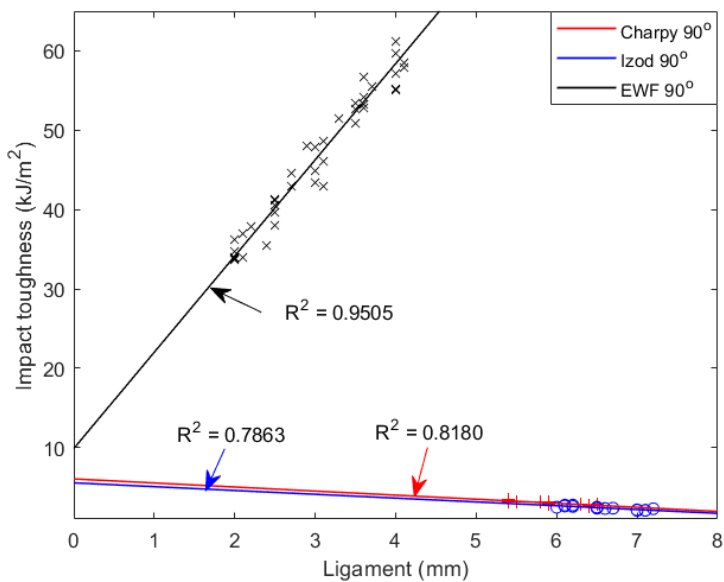
Figure 7. Comparison of the fracture energy calculated by different methods.